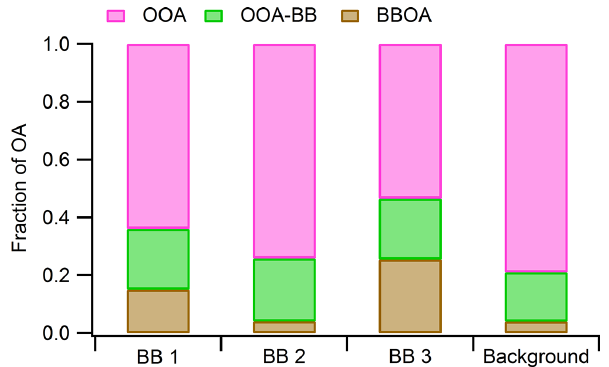
Figure 9. The relative contribution of different types of OA during the three biomass burning events and background